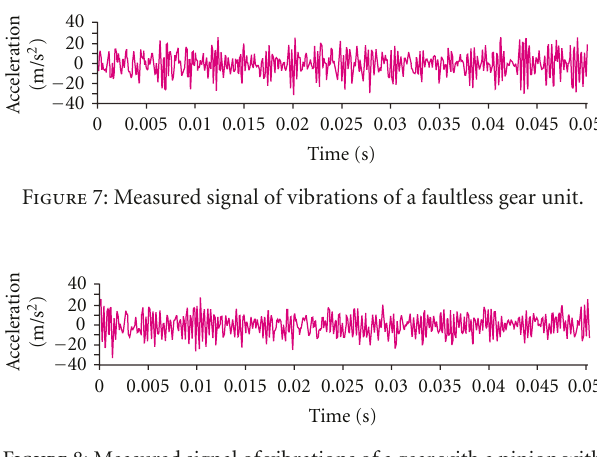
Figure 8: Measured signal of vibrations of a gear with a pinion with a crack.